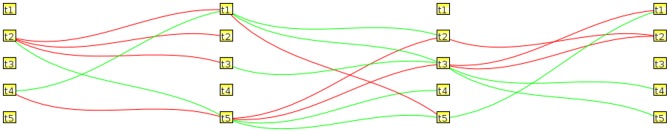
Causal networks for the 5 templates without priming dose in
Figure 2D
.